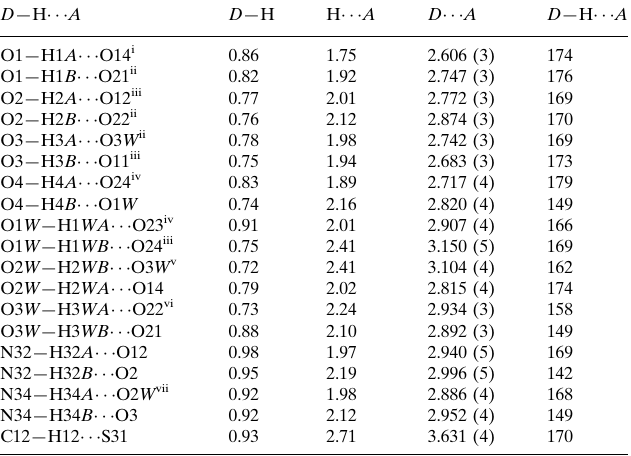
Hydrogen-bond geometry (A˚ , (cid:2)